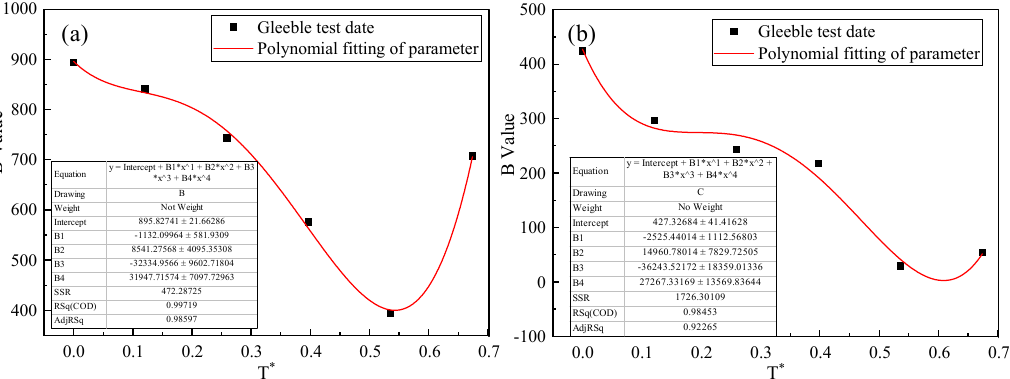
Figure 6. Fitting value of parameter B of 316L and Q235B. ( a ) 316L parameter B fitting value. ( b )